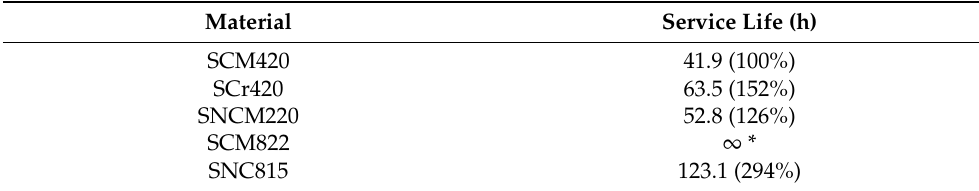
Table 7. Results of service life analyses for the range shift B gears with different materials. Material Service Life (h) SCM420